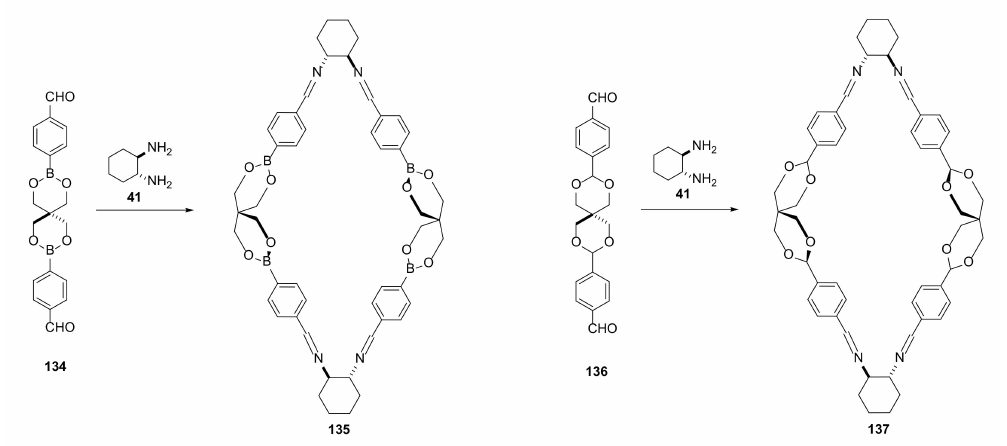
Figure 26. Synthesis of rhombimines with spiro boronic ester ( 135 ) or spiro acetal ( 136 ) moieties in the macrocyclic structure.